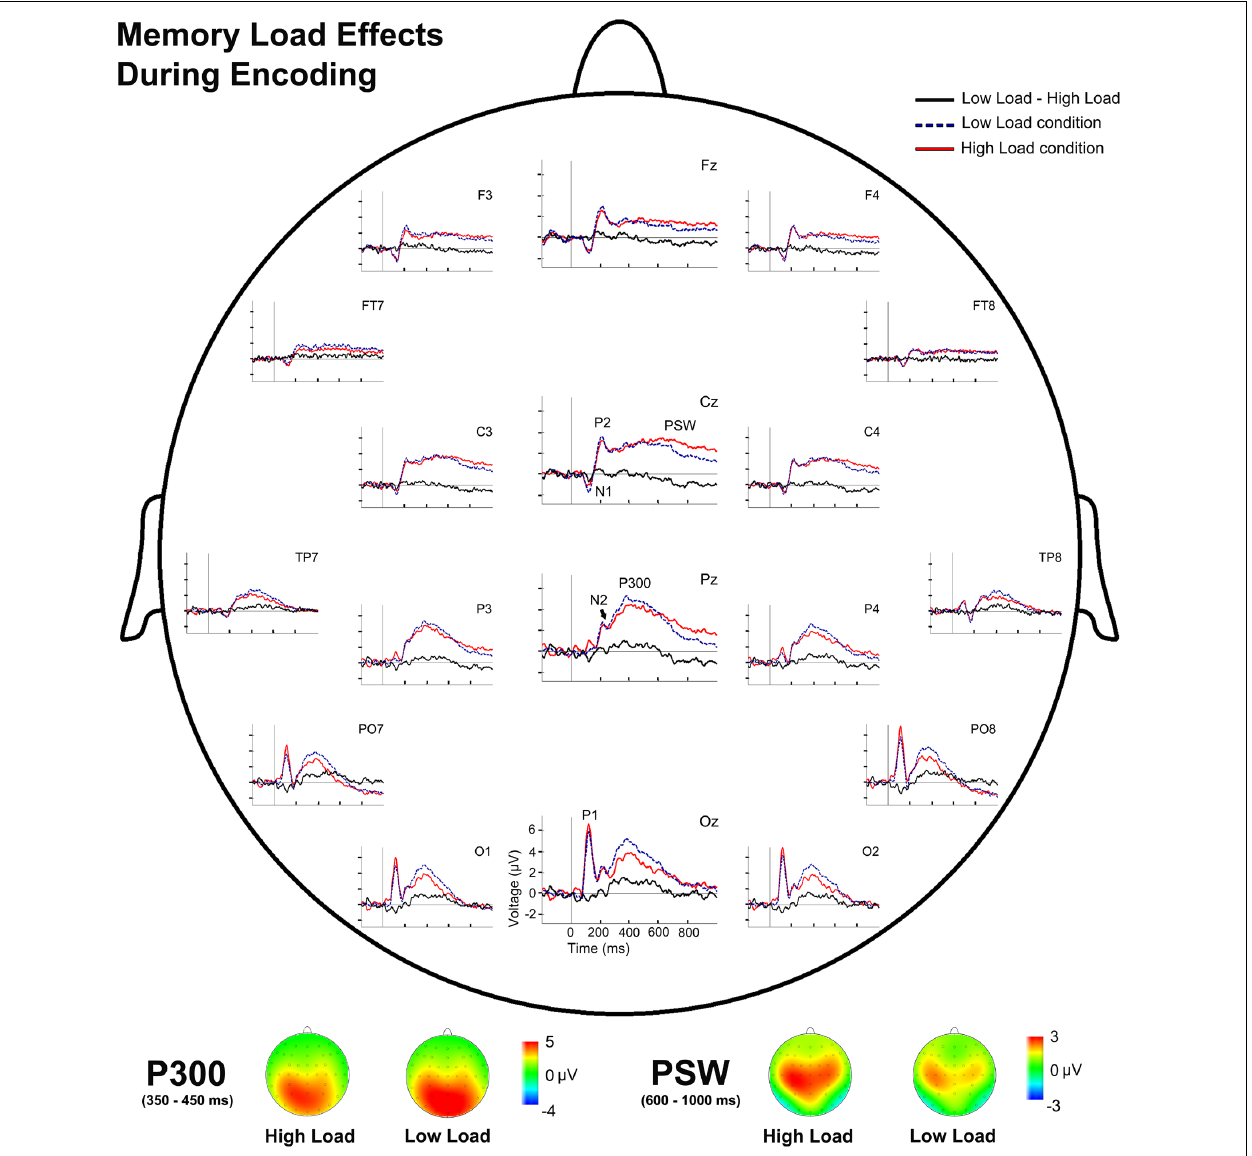
FIGURE 3 | Event-related potentials waveforms during sample stimulus processing and voltage maps for components modulated byWM load. (Top) Topographic plot of the ERP waveforms for bothWM load conditions and their difference (LL-HL) during encoding at several scalp electrodes. (Bottom) P300 and PSW voltage maps for bothWM load conditions during